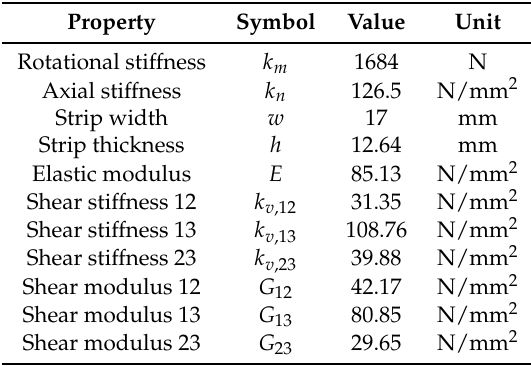
Table 2. Strip element model, estimated stiffness parameters per strip unit